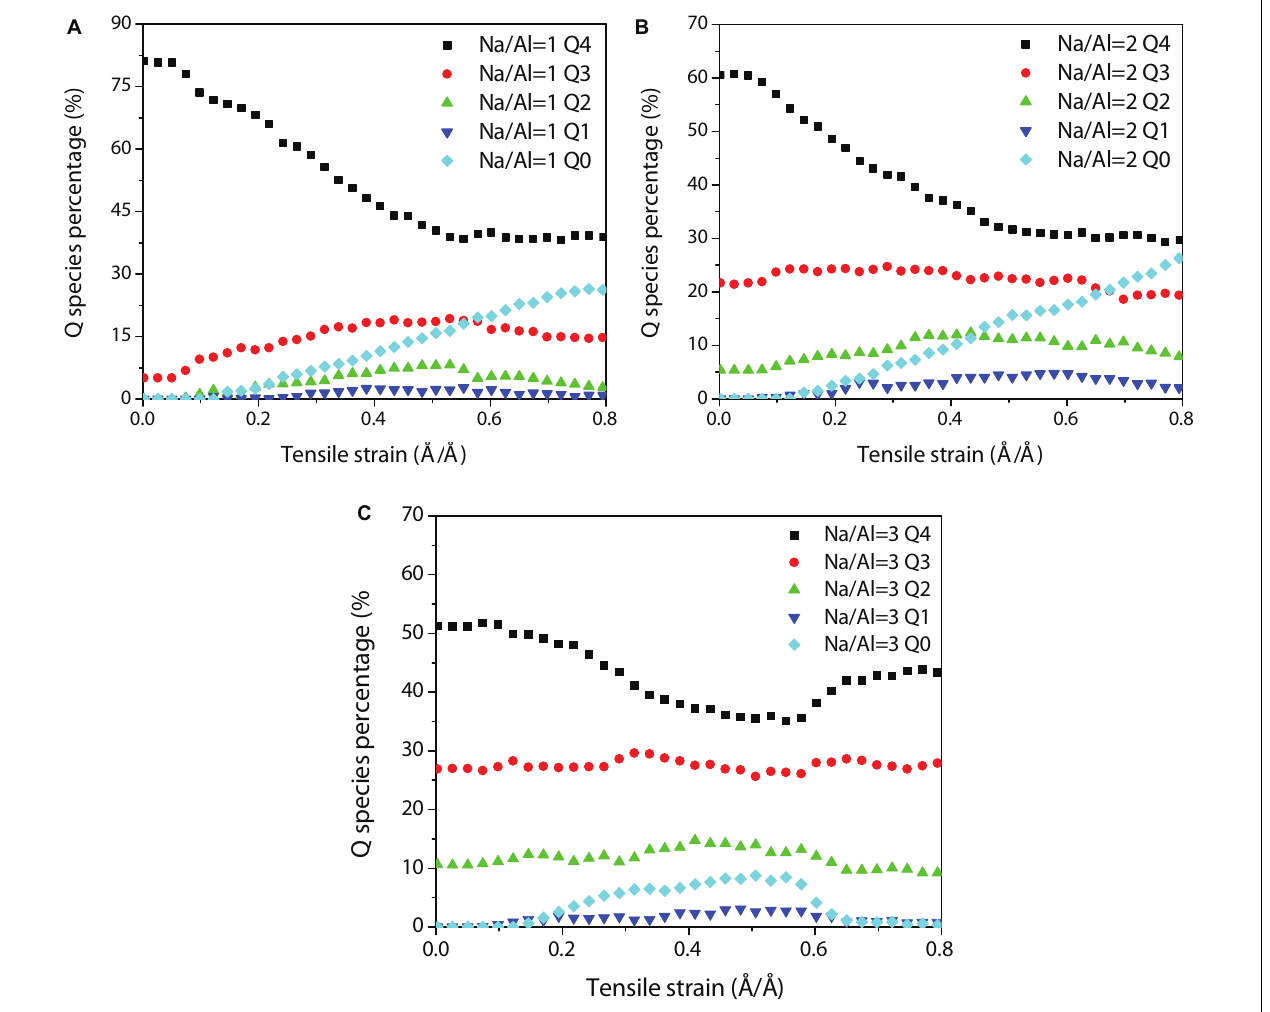
FIGURE 7 | Evolution of Q n species ( n = 0, 1, 2, 3, and 4) for the NASH gel with a Na/Al ratio of (A) 1, (B) 2, and (C) 3 during the tensile process at a strain rate of 0.08 ps.